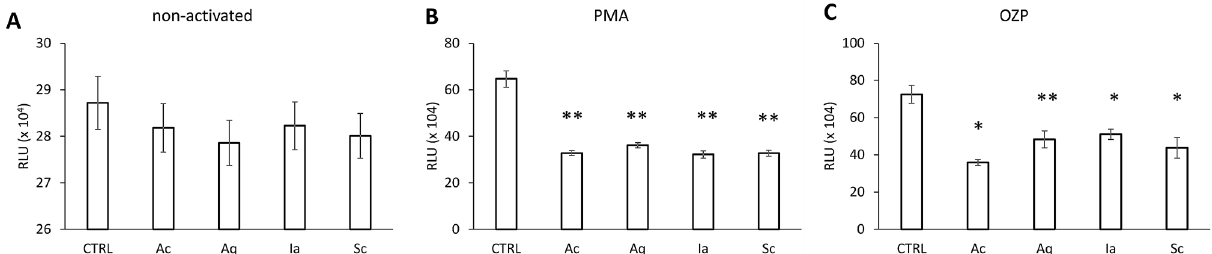
Figure 1. A corrected version of Figure 5. Effect of silver dressings on neutrophil activation. ( A ) Non-activated or ( B ) PMA-, and ( C ) OZP- pre-activated neutrophils were incubated with dressing extracts (in 10% FBS RPMI- media) and their oxidative burst measured. The results represent means of four independent experiments ± SD, *p < 0.05, **p <